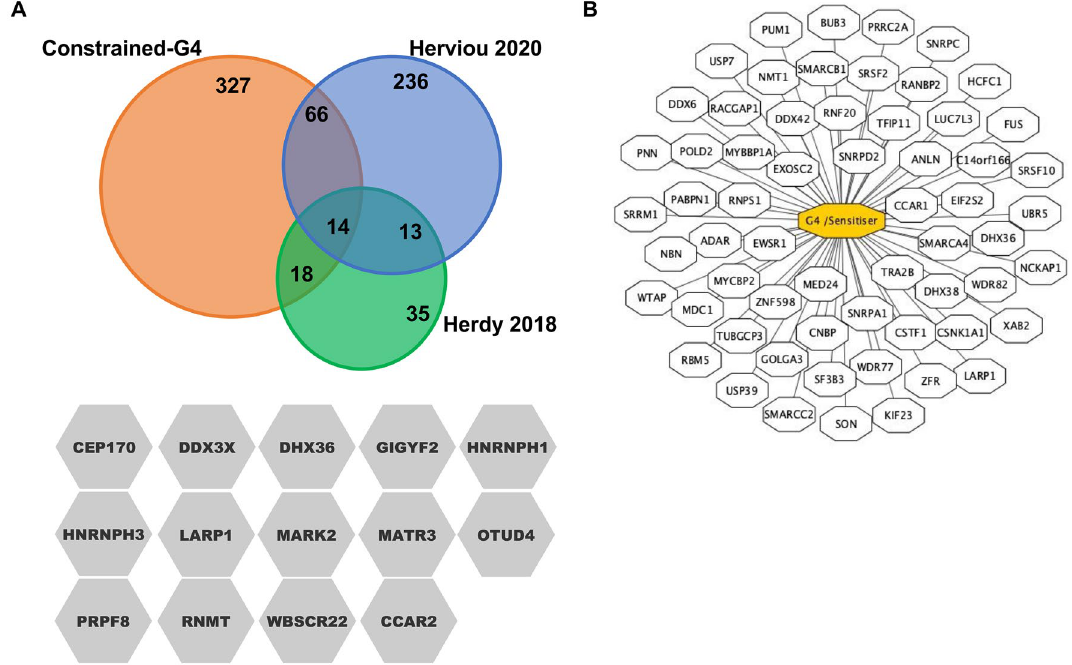
Figure 3. Contrained-G4 interacting factors are associated with RNA-G4 binding activities and with the sensitisation to small molecules that stabilize G4 structures. ( A ) Venn diagram showing the overlap of our study (orange) with the RNA-G4 interacting proteins identified in Herdy 35 (green) and Herviou 36 (blue). 98 out of 425 proteins identified in our study were known to interact with RNA-G4 structures, with 14 indicated factors common to three studies. ( B ) Schematic representation of constrained G4 interacting proteins identified in our study that are associated to an increased sensitivity to G4 ligands, established by Zyner et al. 49 . From this analysis we determined that 62 out of 425 proteins were reported as G4 ligands